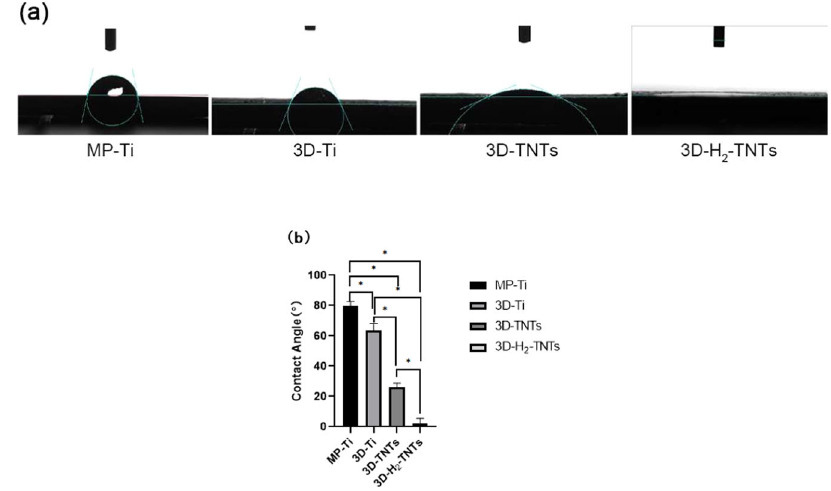
Fig. 2 Sample characterization. SEM images of ( A ) the MP-Ti sub- strate at low magni fi cation (×5000), ( a ) the MP-Ti substrate at high magni fi cation (×50,000); ( B ) the 3D-Ti at low magni fi cation (×500), ( b ) the 3D-Ti at high magni fi cation (×2000); ( C ) the 3D-TNTs at low